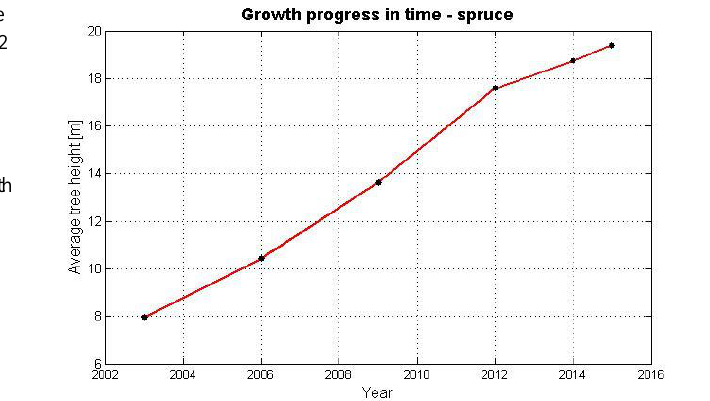
Figure 2. Progress of the growth of trees in the test area.